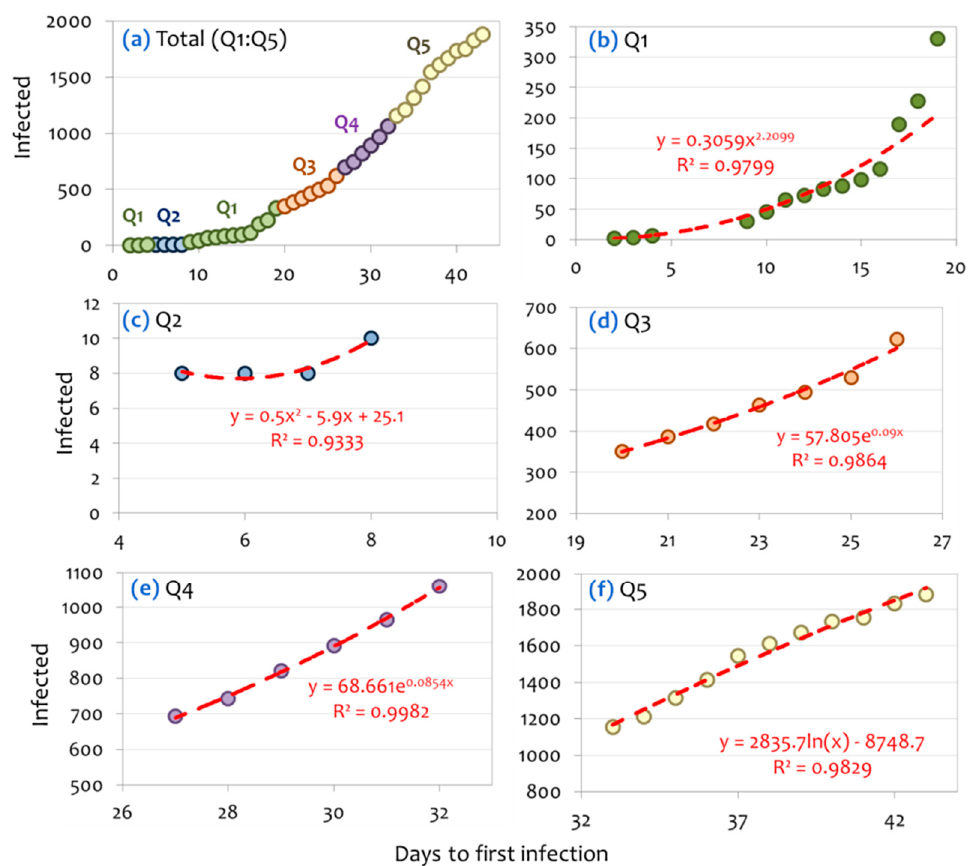
Figure 5. ( a ) The community structure of the Greek COVID-19 infection curve, where ( b – f ) show the best (of the highest R 2 ) fittings within each community.